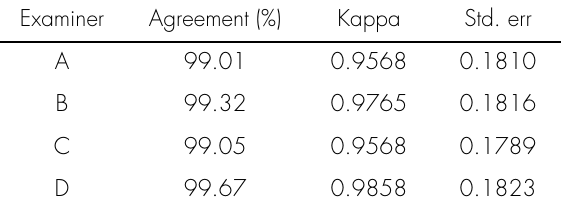
Table III. Intra-examiner agreement and Kappa of the IOTN-AC for the study models. Examiner